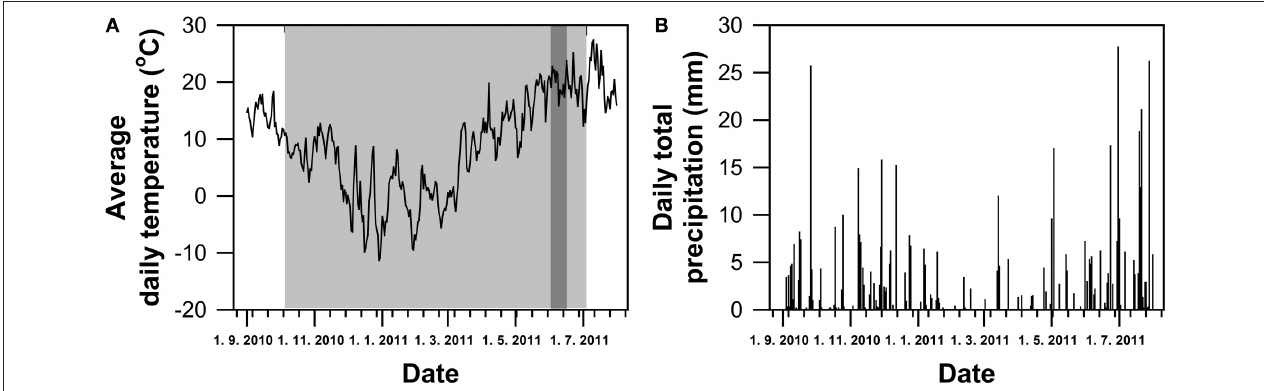
FIGURE 1 | Climatic variables (average daily temperature—(A) and daily total precipitation—(B)) during the grown period of winter wheat. Gray and dark-gray areas represents time of cultivation period and dehydration, respectively.